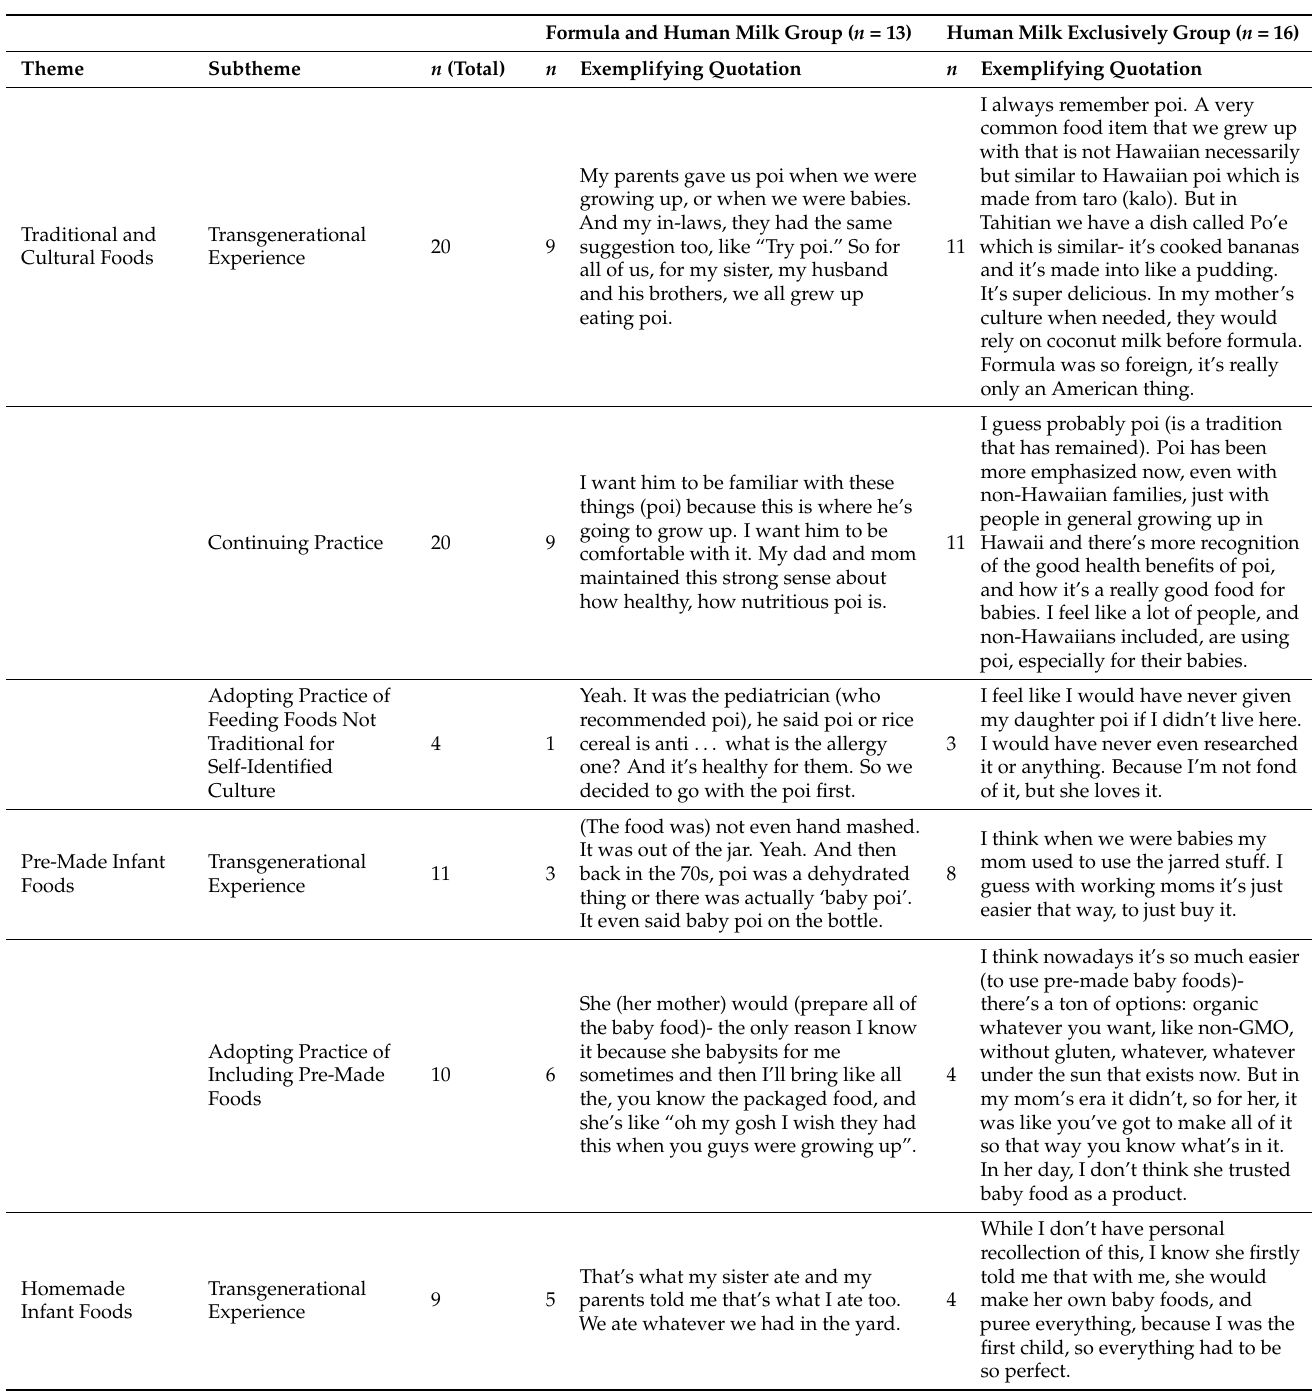
Table 4. Themes and subthemes relating to Transgenerational and Contemporary Complementary Feeding Practices: First Complementary Foods, with exemplifying quotes taken verbatim from in-depth interviews with Native Hawaiian and Other Pacific Islander, and Filipino caregivers, n =